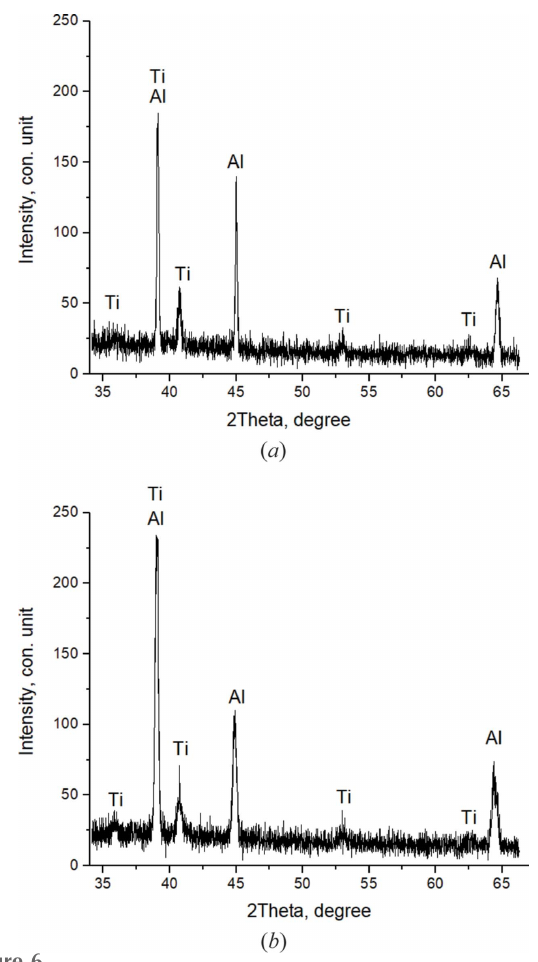
Figure 6 Diffractograms of the 1st ( T = 410.7 (cid:3) C) ( a ) and the 15th ( T = 615.7 (cid:3) C) ( b ) shot.